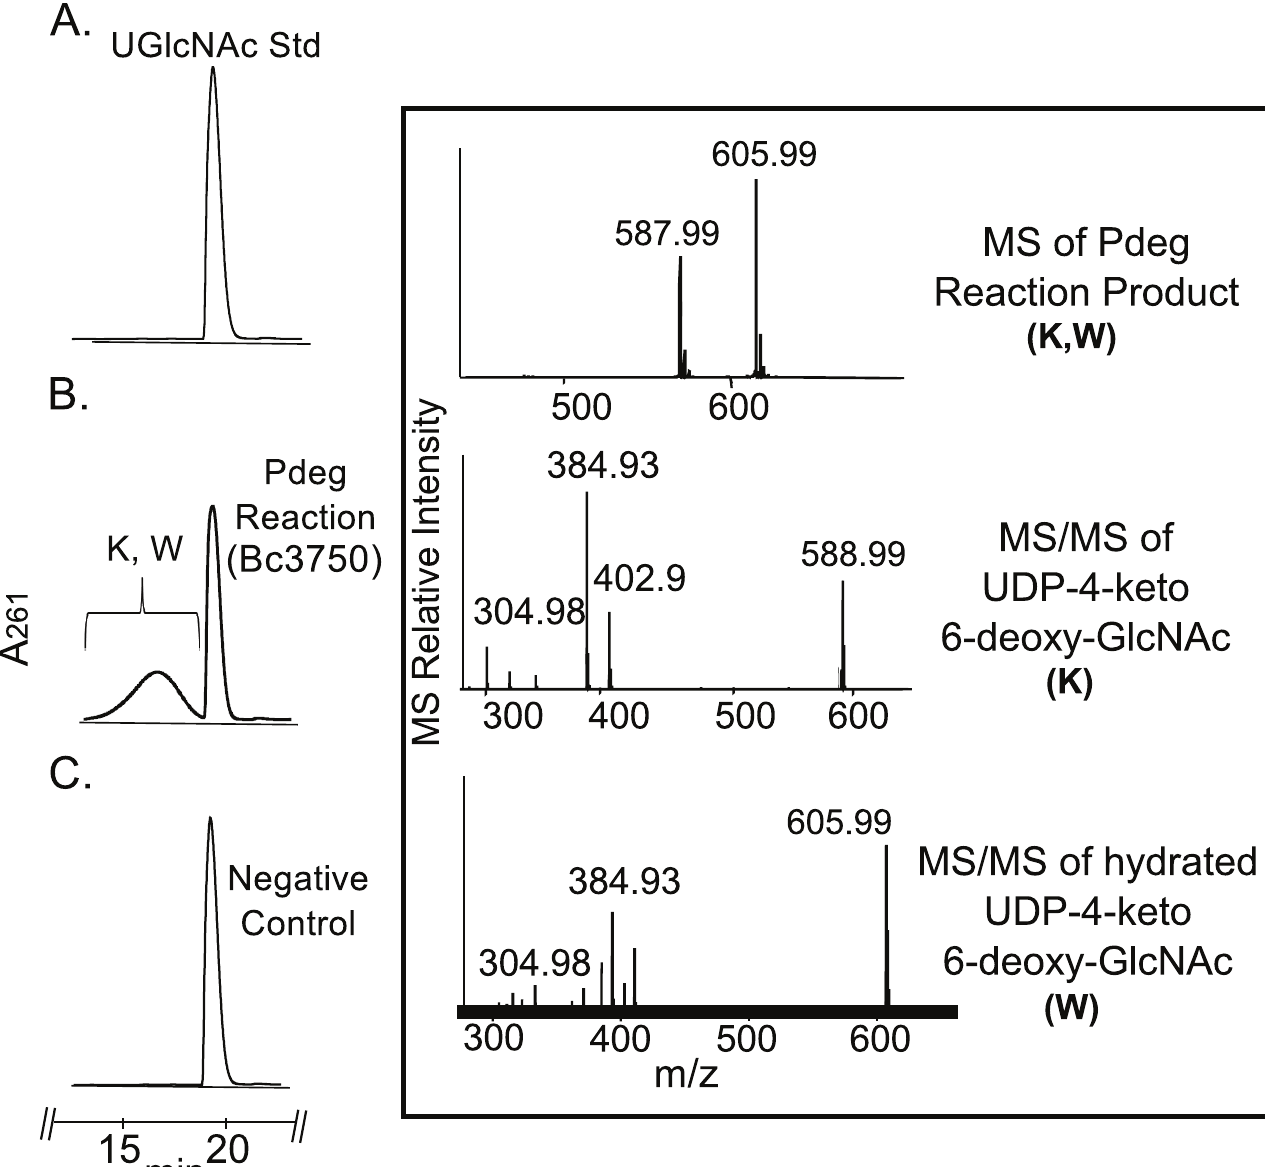
Fig 3. Analysis of recombinant enzyme reaction Pdeg by UV-HPLC and LC-ESI-MS-MS. A. UDP-GlcNAc standard reaction is shown. B. UDP-GlcNAc C4,6-dehydratase reaction, is the conversion of UDP-GlcNAc to UDP-4-keto-6-deoxy-HexNAc. The broad peak (K and W) denotes 4-keto and 4-hydrated- keto form of the UDP-4-keto-6-deoxy-sugar. Boxed top panel shows the product ions, K and W, m/z 587.99 and 605.99, respectively. MS-MS analysis of parent ions K and W gave fragment ions at m/z 402.9, 384.9 and 304.9 that are consistent with [UDP-H] - , [UDP-H 2 O-H] - , and [UMP-H 2 O-H] - , respectively. (Boxed the second and third panel) C. Pdeg negative control reaction carried out with unrelated